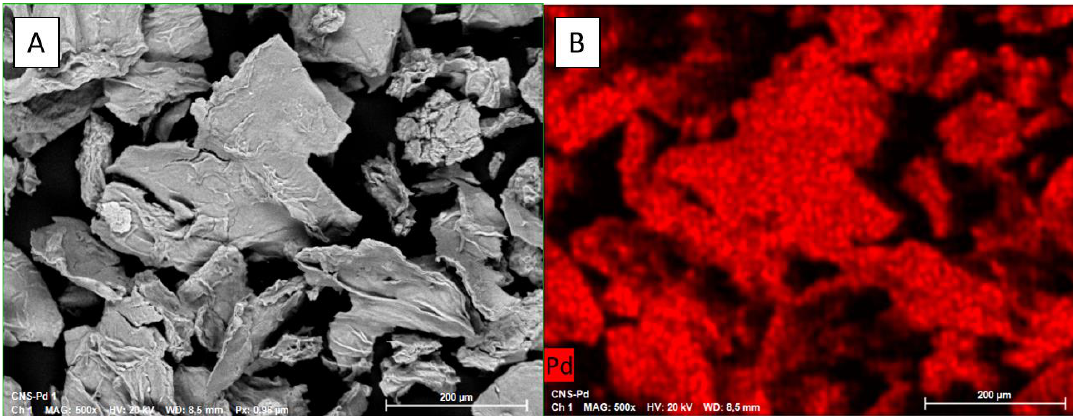
Figure 1. SEM images of CNS-Pd ( A ) and distribution of Pd on the catalyst’s surface, obtained with EDS ( B ).